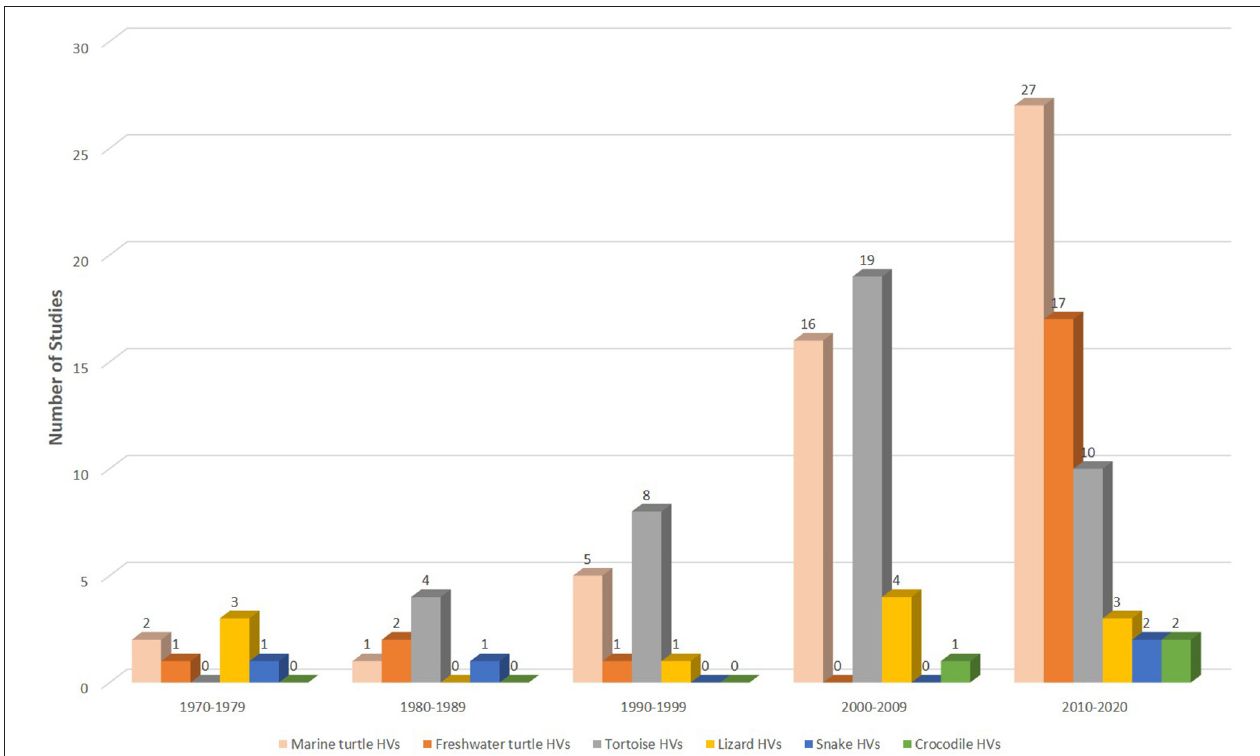
FIGURE 2 | Studies on HVs in reptiles from 1972 to September 8, 2020. Overall, more than a quarter ( n = 51; 39%) of the 130 extracted studies were conducted in marine turtles since the 1970s. Of the 60 publications between 2010 and 2020, 45% ( n = 27) were ChHV-5 related studies.